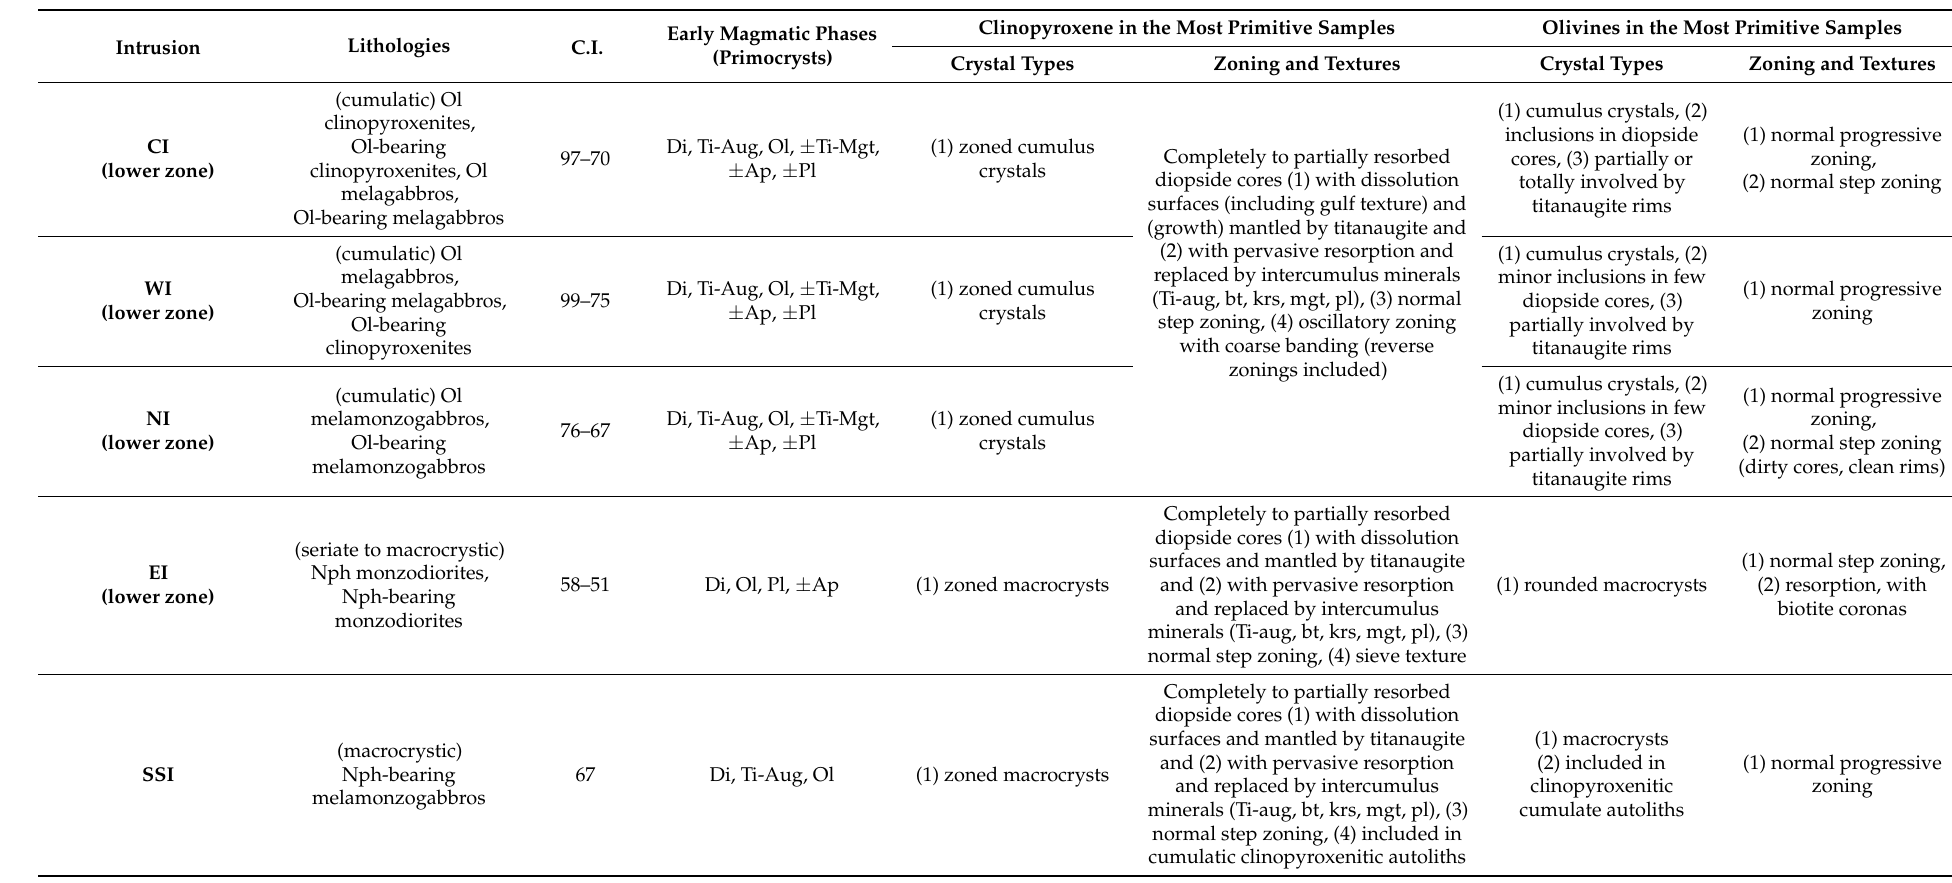
Table 1. Summary of clinopyroxene and olivine paragenesis in the main intrusions of the Ponte Nova mafic–ultramafic alkaline